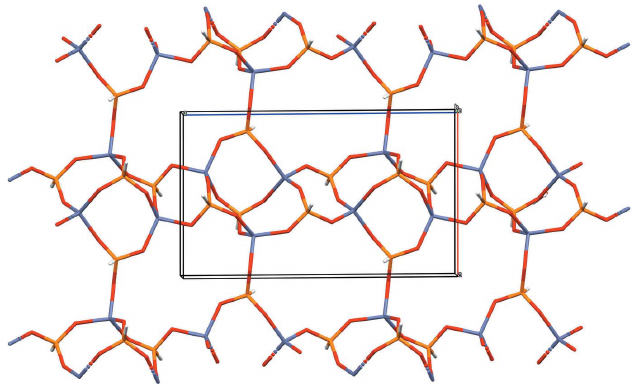
Figure 7 Part of an infinite (010) layer of vertex sharing ZnO 4 and HPO 3 moieties in the extended structure of (IV) viewed down [010].